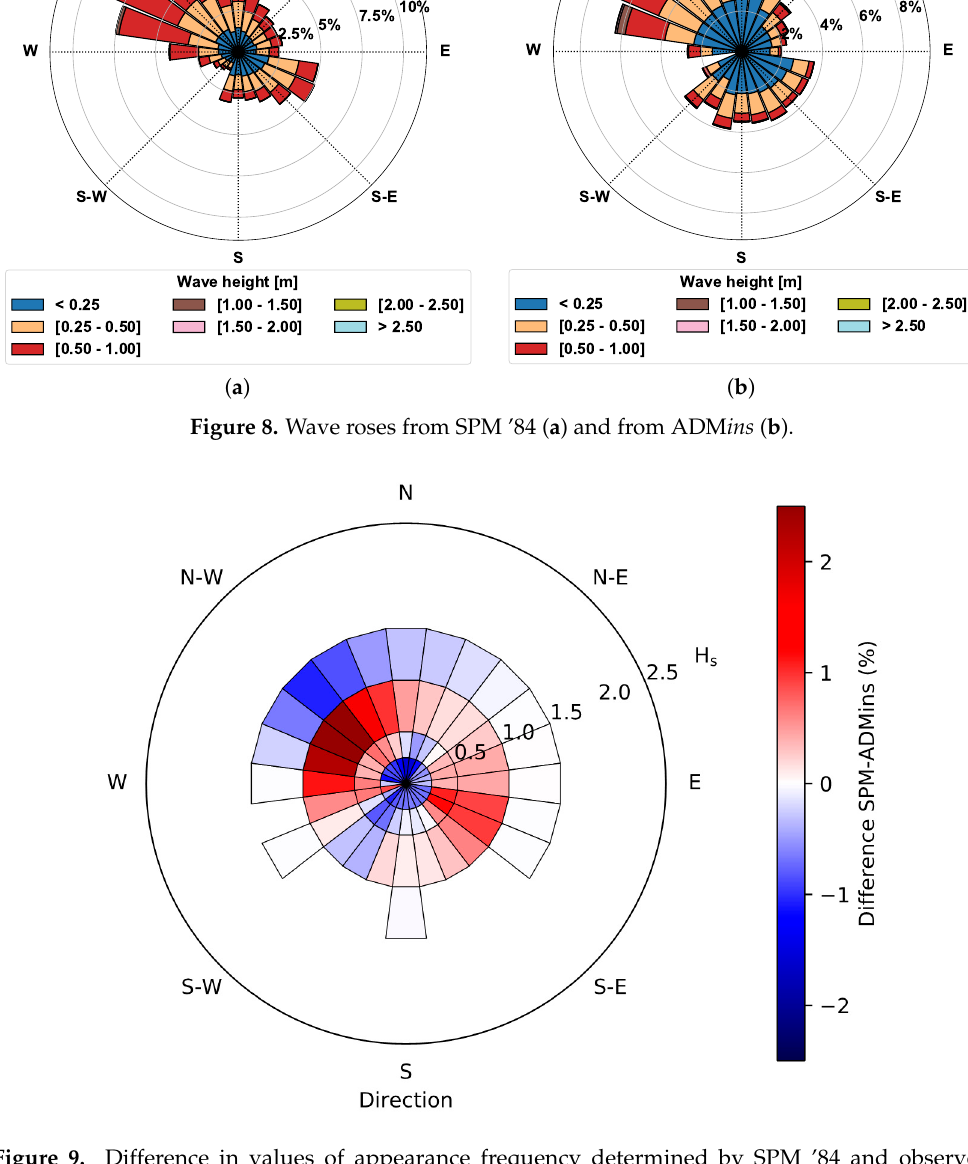
Figure 9. Difference in values of appearance frequency determined by SPM ’ 84 and observed by ADM ins.